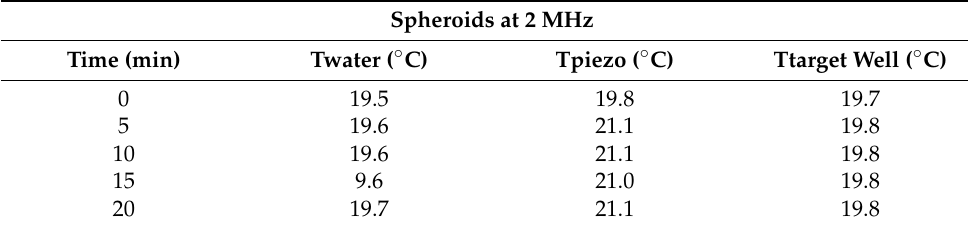
Table 2. Average temperature values calculated at 2 MHz.